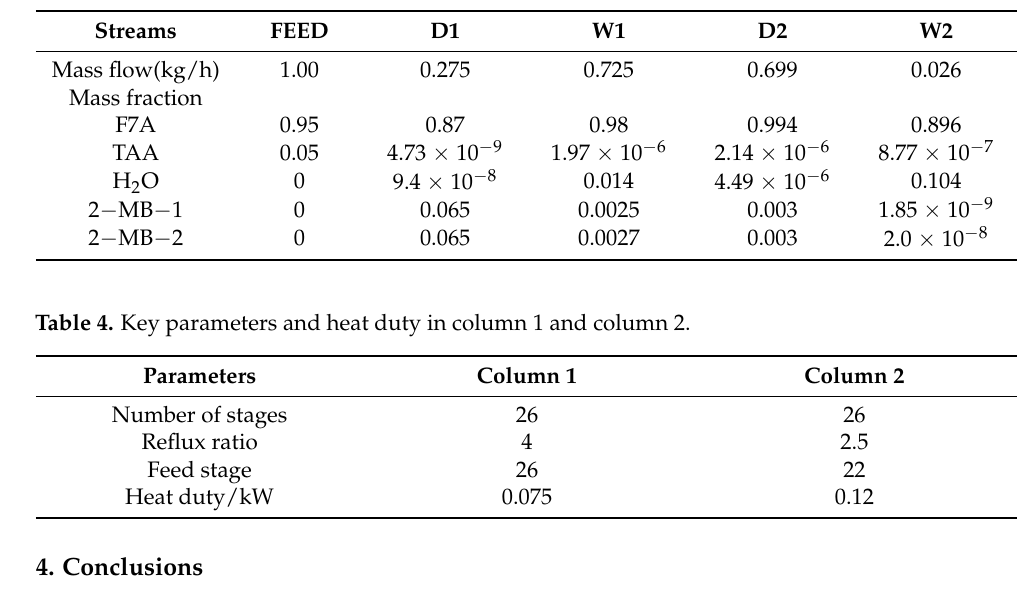
Table 3. Mass flow and mass fraction in all streams. Streams FEED